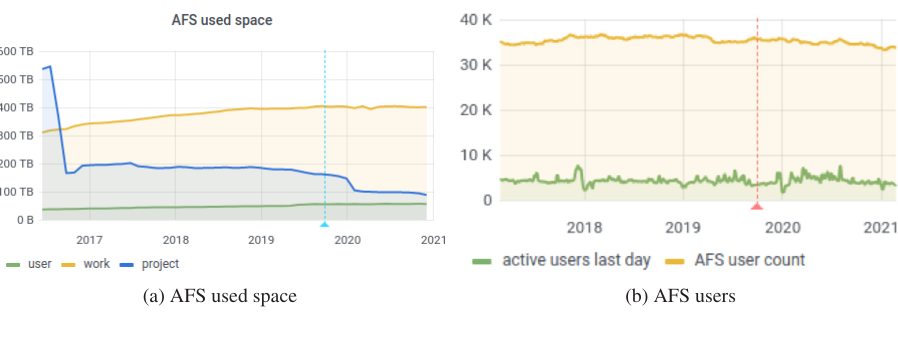
Figure 5: migration veto